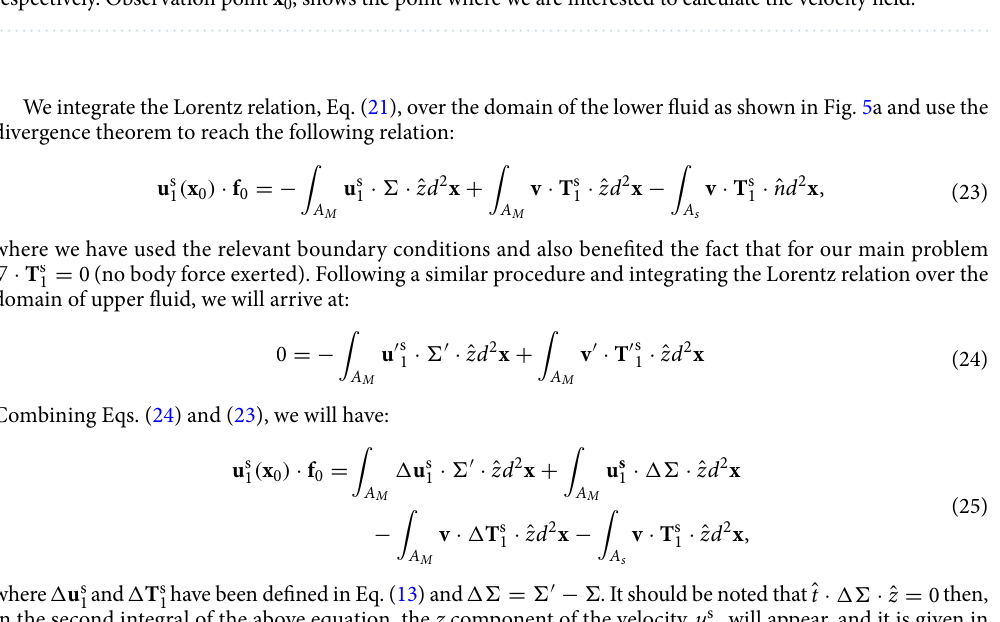
Figure 5. The boundaries of our main problem and the auxiliary problem are shown in parts ( a ) and ( b ), respectively. Observation point x 0 , shows the point where we are interested to calculate the velocity